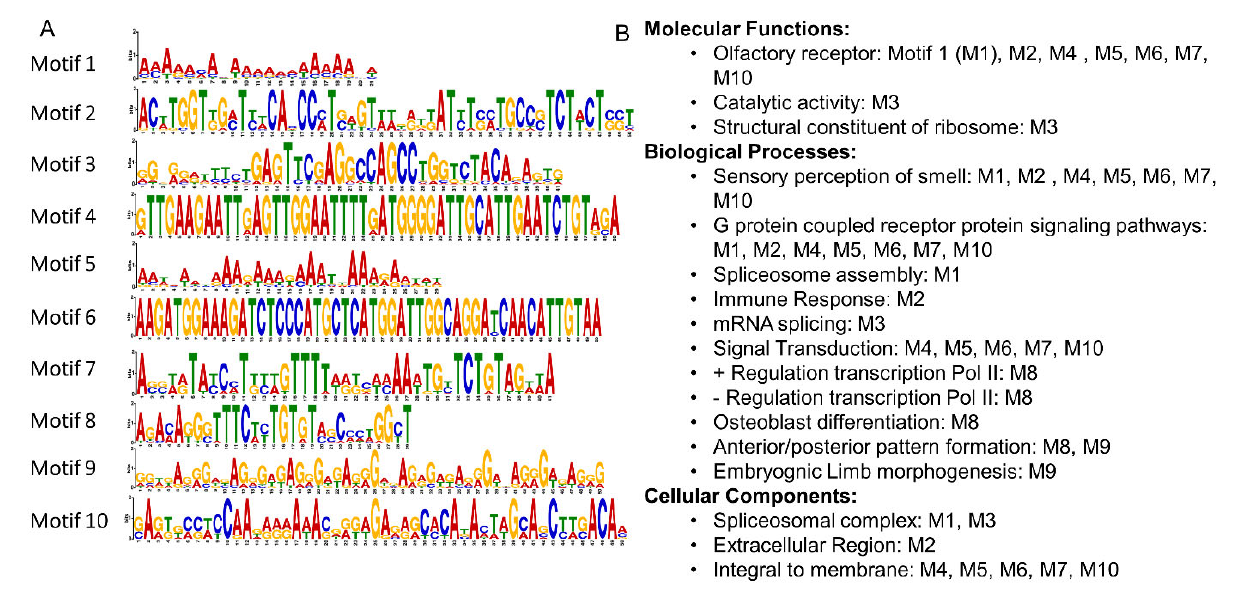
Figure 2. DNA sequence motifs shown as a sequence logo. ( A ) The 10 motifs were found de novo across the 118 hit genes found in HO-1 ChIP-seq. ( B ) Molecular functions, biological processes, and cellular components related to the motifs found in ( A ) when comparing those motifs to motifs found across the entire human genome.